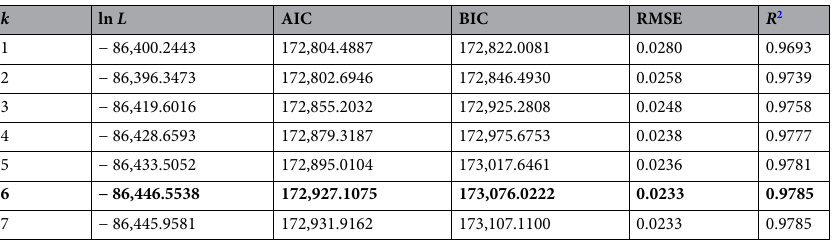
Table 7. Comparison results with different components for circular variable. A voM mixture model with six-component distributions is the optimal model for correlation circular variable between wind speed and direction. The results of the best model are in bold